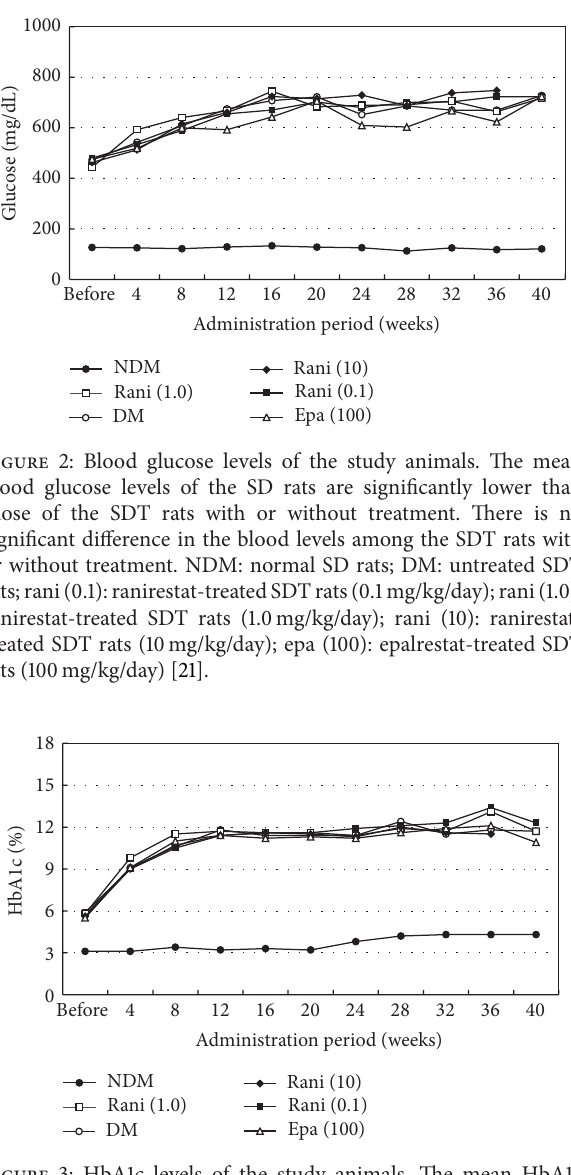
Figure 3: HbA1c levels of the study animals. The mean HbA1c levels of the SD rats are significantly lower than those of the SDT rats with or without treatment. There is no significant dif- ference in the HbA1c levels among the SDT rats with or with- out treatment. NDM: normal SD rats; DM: untreated SDT rats; rani (0.1): ranirestat-treated SDT rats (0.1mg/kg/day); rani (1.0): ranirestat-treated SDT rats (1.0mg/kg/day); rani (10): ranirestat- treated SDT rats (10mg/kg/day); epa (100): epalrestat-treated SDT rats (100mg/kg/day) [21].